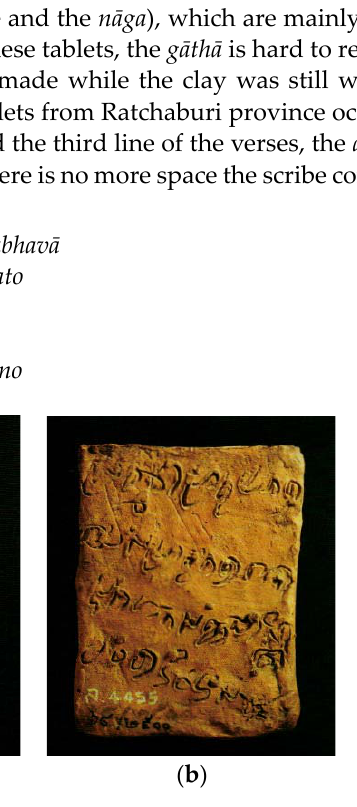
Figure 2. The Śrāvastī miracles (Buddha meditating beneath a blooming tree and the nāga) with ye dhammā formula. Ca. the first half of the 8th century CE. Ratchaburi province. Moulded tablet, clay; h. 14 × w. 11 cm. U‑Thong National Museum (No. 64/2510). ( a ) Font Side; ( b ) back Side. After Bhumadhon and Phongpanit (2015 [2558 BE], fig. 11–69).